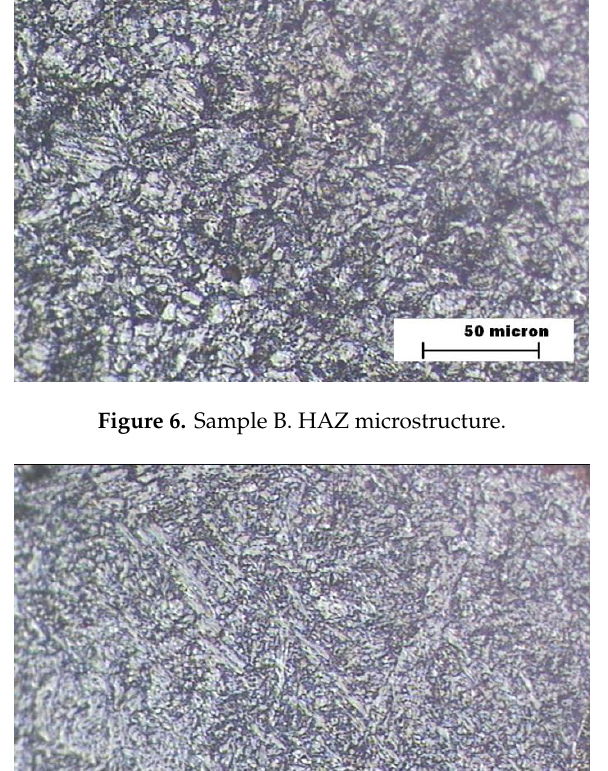
Figure 8. Sample C. HAZ microstructure.